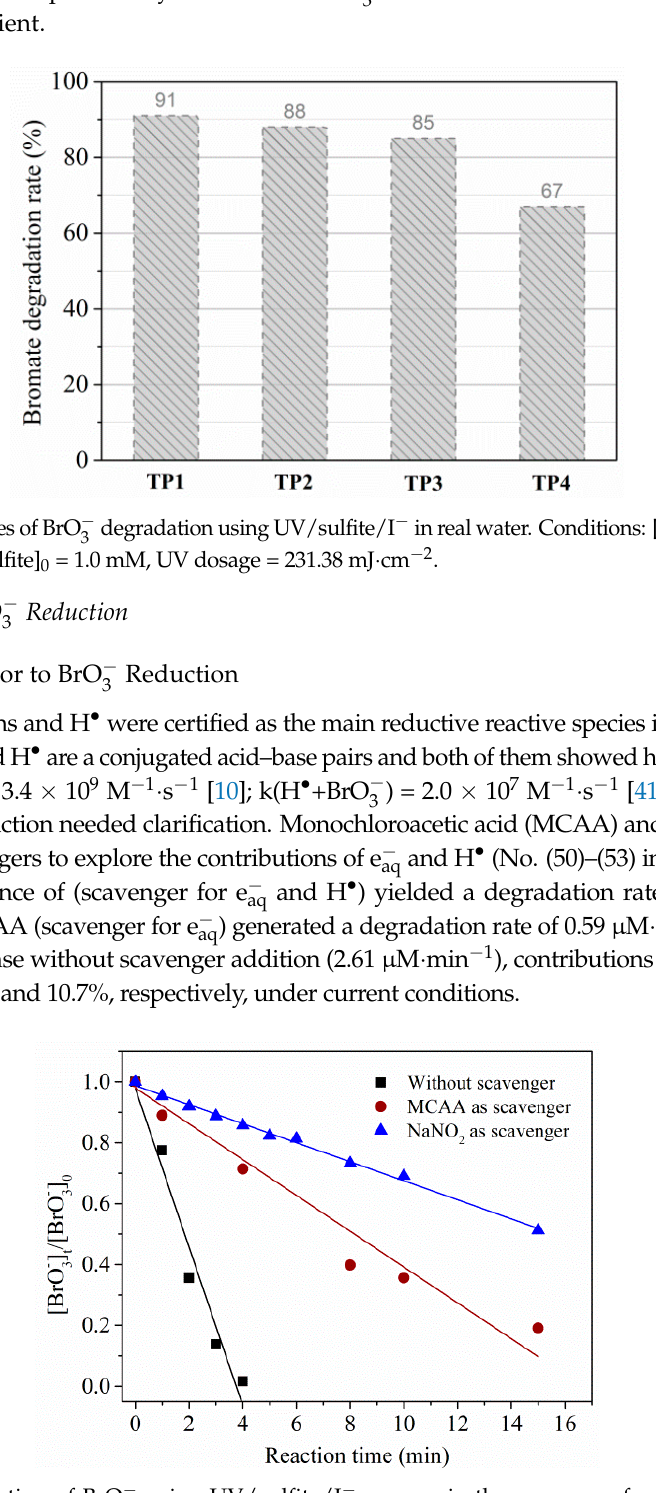
Figure 3. Degradation of BrO (cid:2871)(cid:2879) using UV/sulfite/ I (cid:2879) process in the presence of monochloroacetic acid ( MCAA ) and NO (cid:2870)(cid:2879) . Conditions: [ BrO (cid:2871)(cid:2879) ] 0 = 10 μ M, [ I (cid:2879) ] 0 = 100 μ M, [sulfite] 0 = 1.0 mM, [ MCAA ] 0 = 1.0 mM, − ] 0 = 4.0 mM, [DO] 0 = 7.0 mg · L − 1 , pH = 9.2, 20 ± 1 ◦ [ NO (cid:2870)(cid:2879) ] 0 = 0.4 mM, [DO] 0 = 7.0 mg·L − 1 , pH = 9.2, 20 ± 1 °C. [MCAA] 0 = 1.0 mM, [NO 2